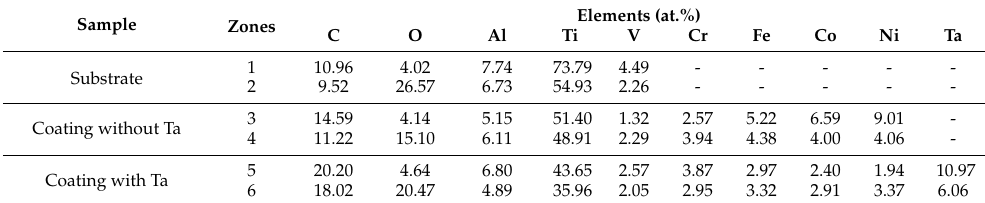
Table 6. Chemical compositions of marked zones shown in Figure